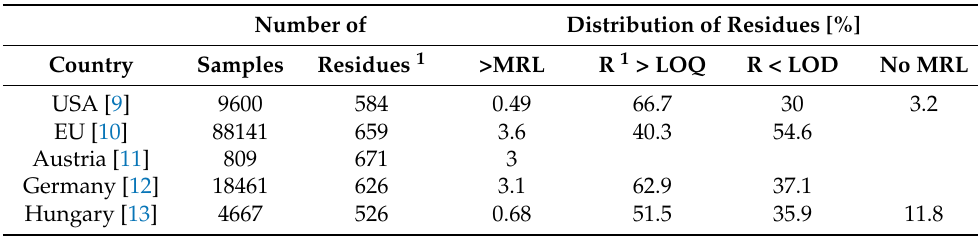
Table 1. Examples for the reported results of national pesticide residue monitoring programmes conducted in 2020. Number of Distribution of Residues [%] Country Samples Residues 1 >MRL R 1 >